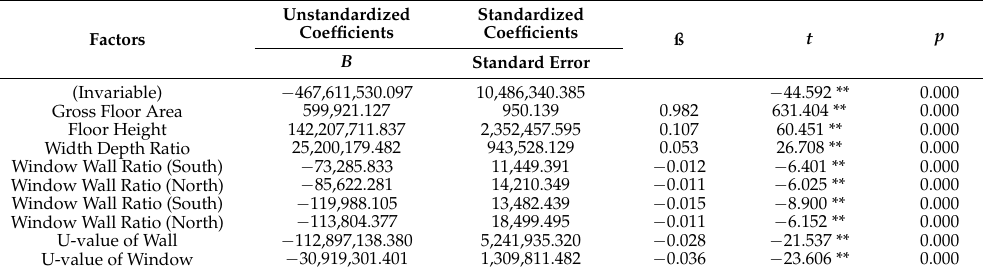
Table 6. Coefficient of Equations of the Initial Cost Prediction.